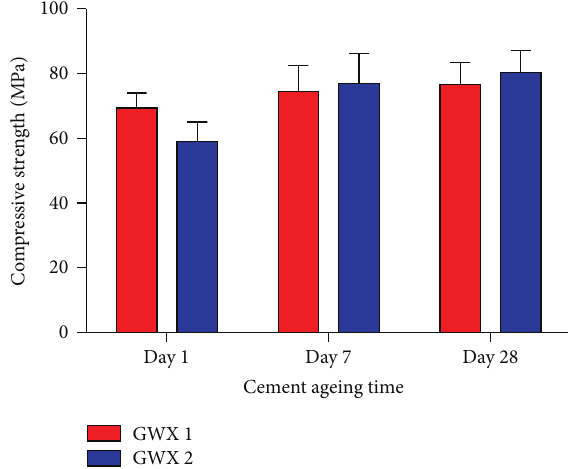
Figure 2: The compressive strength of GPCs for GWX 1 and GWX 2 at 1, 7, and 28